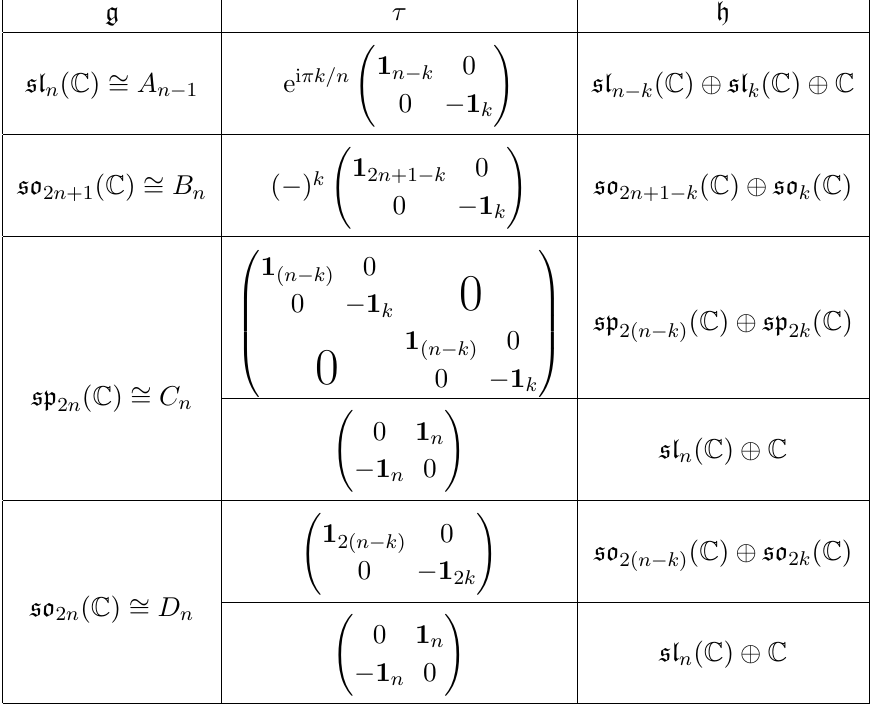
Table 1 . Involutive inner automorphisms of classical g